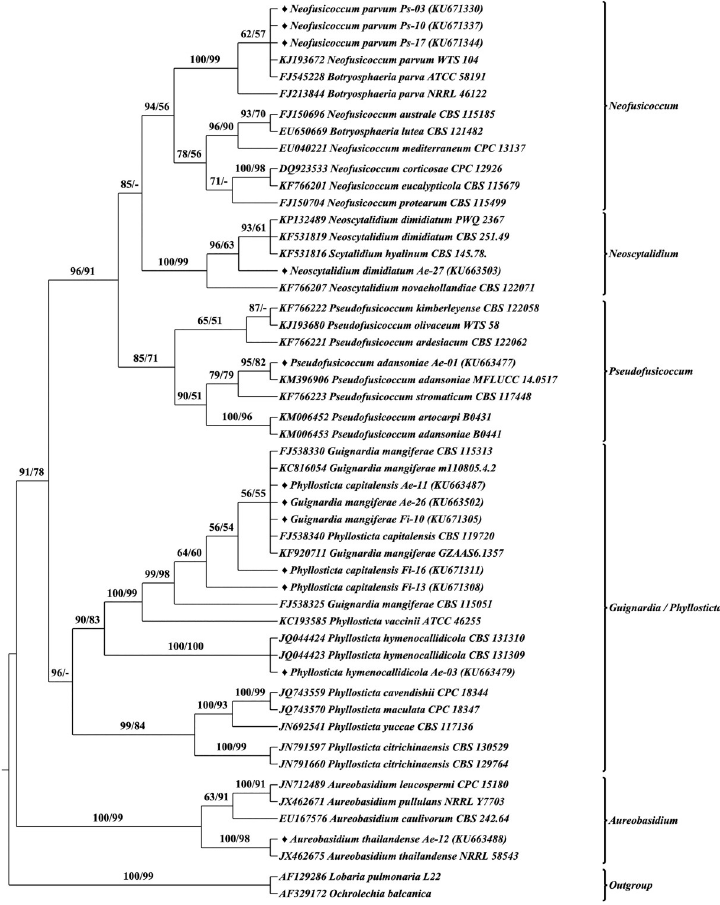
Fig 7. Internal transcribed spacer 2 sequence–secondary structure based phylogenetic tree of Botryosphaeriales and Dothideales query and reference sequences. The query sequences are represented by the symbol “ ♦ ”. Bootstrap (BP) values � 50 were represented in the tree. Maximum Likelihood tree was presented with branch support values as BP of ML tree / BP of NJ tree.